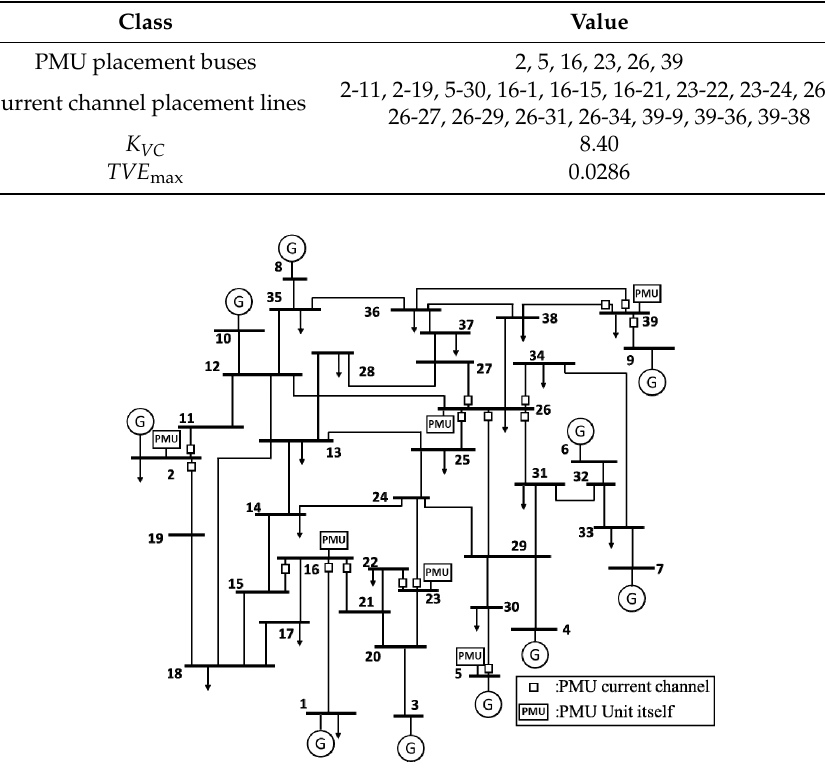
Figure 5. Satisfaction degree in each method. Table 5. The details of the Best Compromised Solution (BCS).